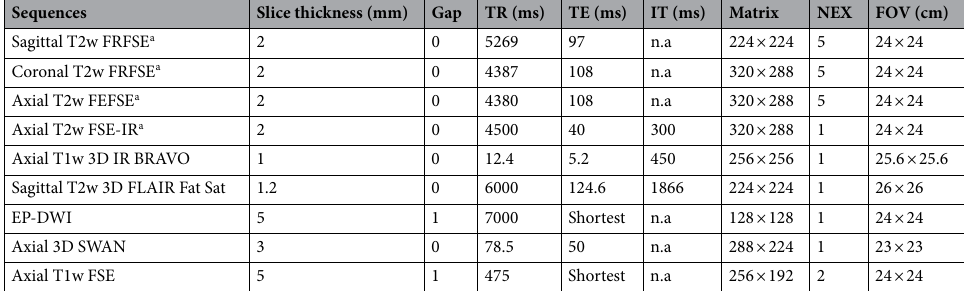
Table 1. MRI acquisition parameters used for screening and follow-up studies with 1.5 T MRI scanner. TR repetition time, TE echo time, TI inversion time, NEX number of excitations, FOV field of view, FRFSE fast recovery fast spin echo, FSE fast spin echo, IR inversion recovery, BRAVO brain volume acquisition, FLAIR Fat Sat fluid-attenuated inversion-recovery with fat signal saturation, EP echo planar, DWI diffusion weighed imaging, SWAN susceptibility-weighted angiography. a Basal ganglia